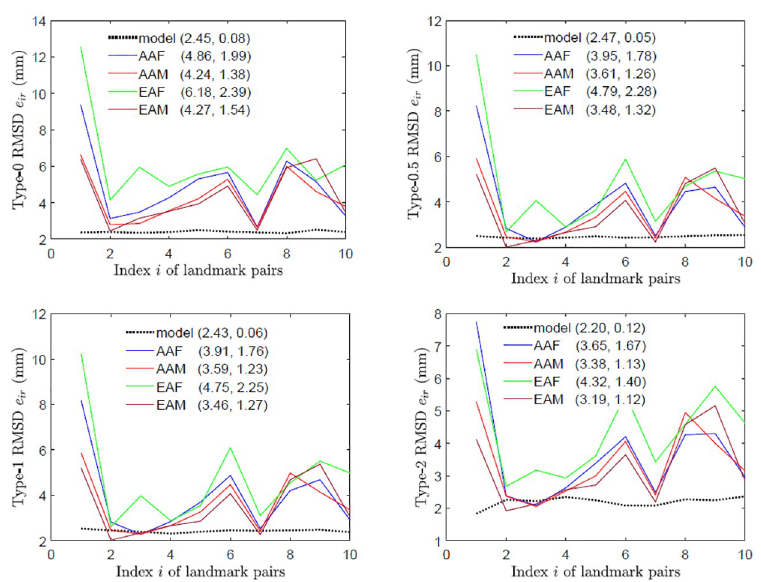
Fig 5. Asymmetry of landmark pairs. The plots are for the perturbed symmetric skulls (model) and original skulls with respect to different assessment types (0, 0.5, 1 and 2) and in different categories (AAF, AAM, EAF and EAM), where in brackets are the means and standard deviations of the RMSDs for asymmetry